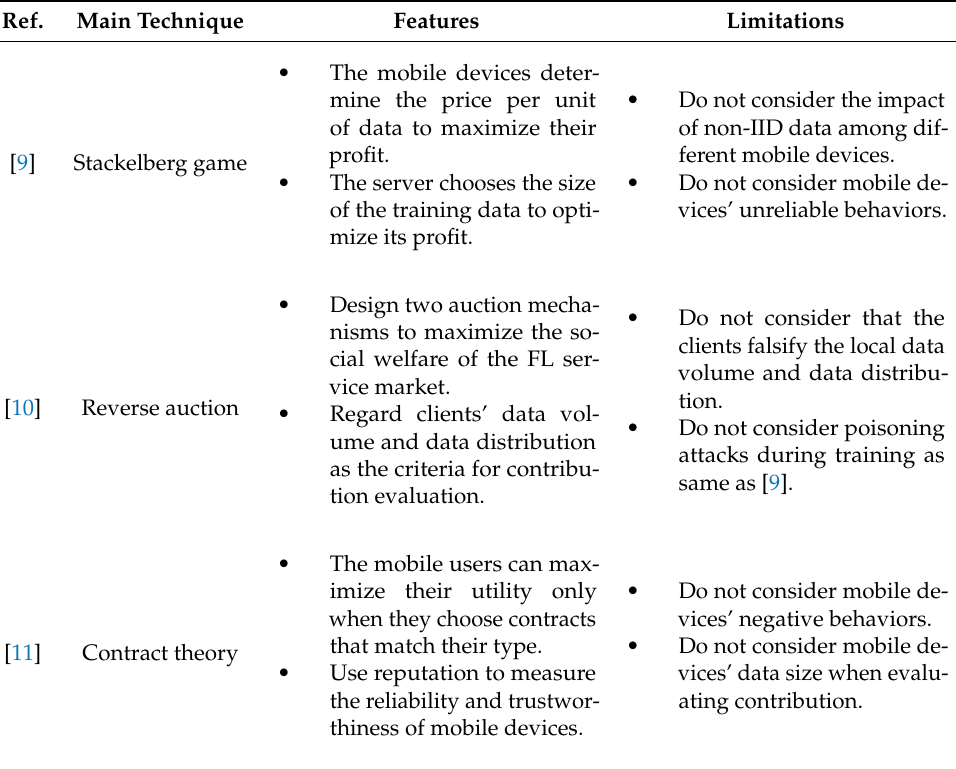
Table 1. Summary of the main technique, features, and limitations in the existing incentive mecha- nisms for